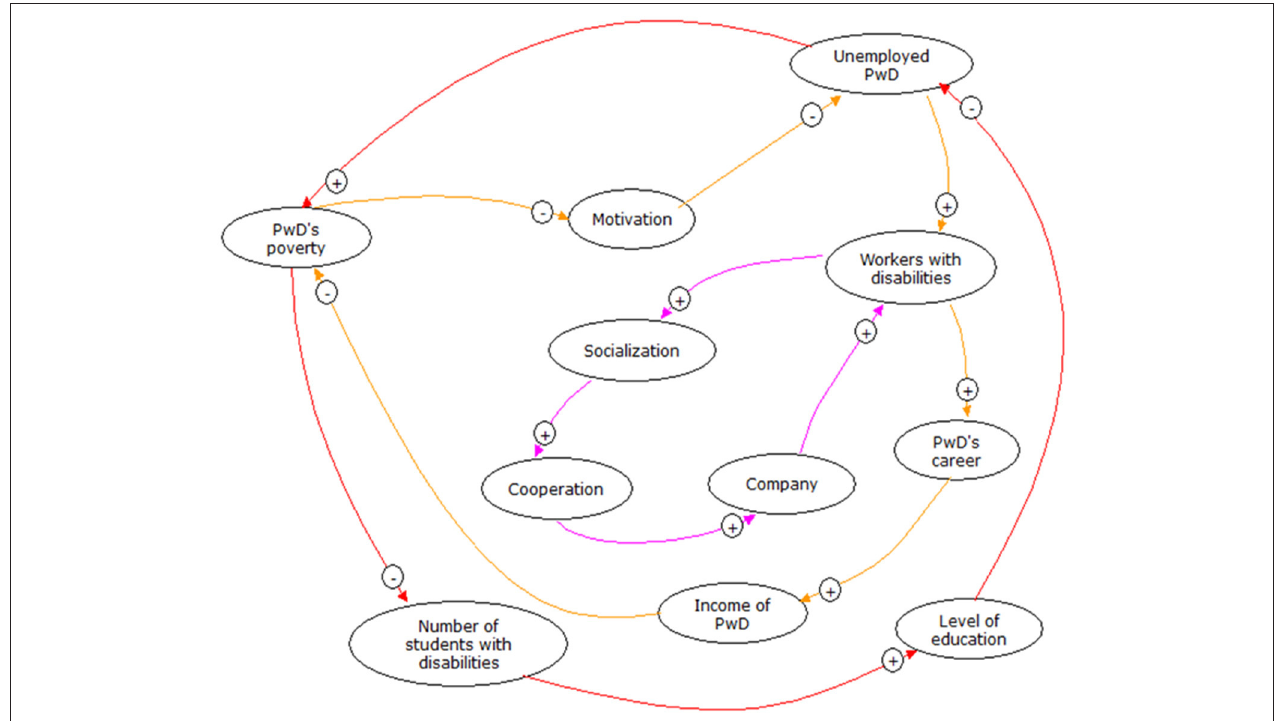
FIGURE 2 | Casual loop inclusiveness of people with disabilities at work. The “ + ” symbol indicates unidirectional causality, and the “ − ” symbol in the arrow represents the opposite directions of causality.